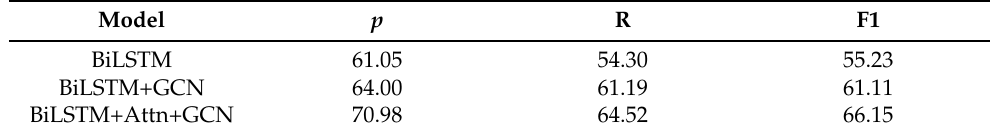
Table 2. Results of ablation experiments with different models (unit: %).